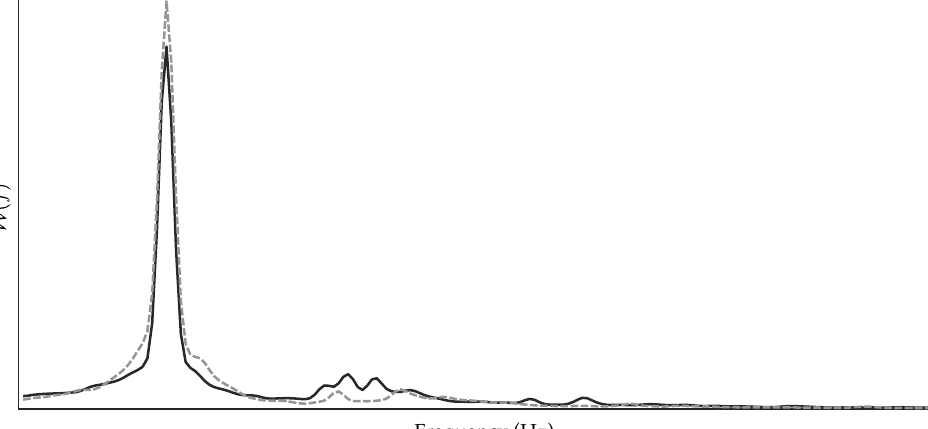
Figure 3. Averaged spectral distributions for all the 6 s ECG segments from patients who relapsed to AF (dashed, gray line) and those who maintained SR after the follow-up (solid, black line) once they were aligned with respect to the